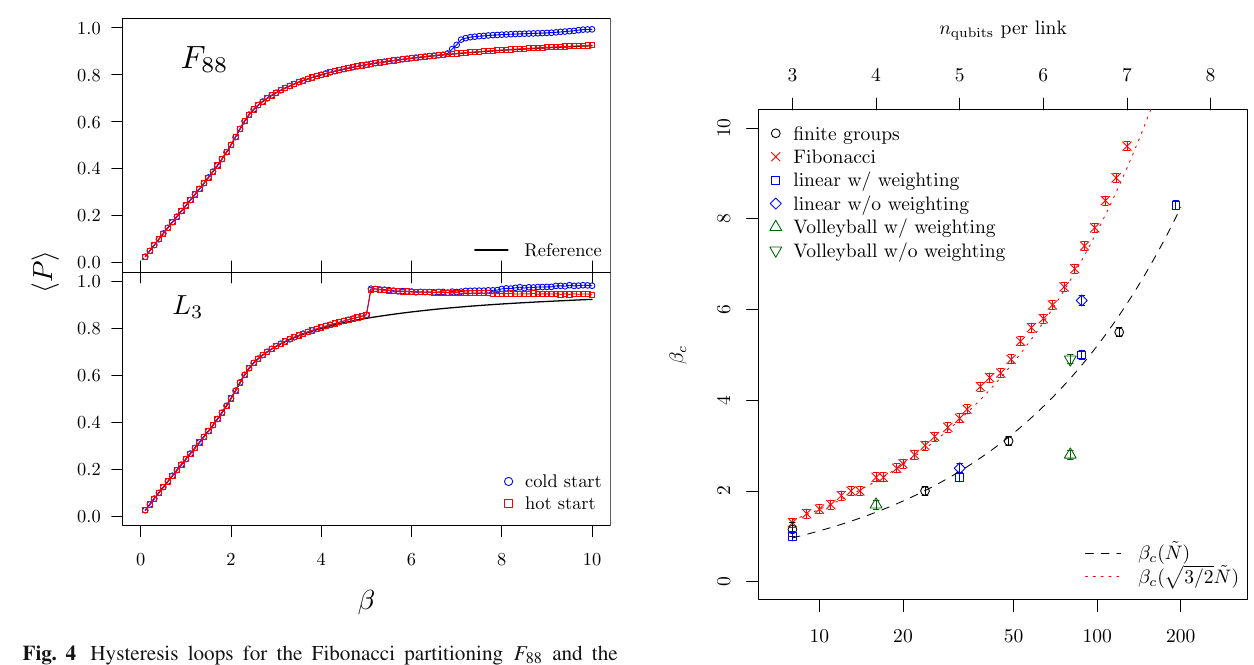
Fig. 4 Hysteresis loops for the Fibonacci partitioning F 88 and the linear partitioning with weights included L 3 . Both have n = 88 elements